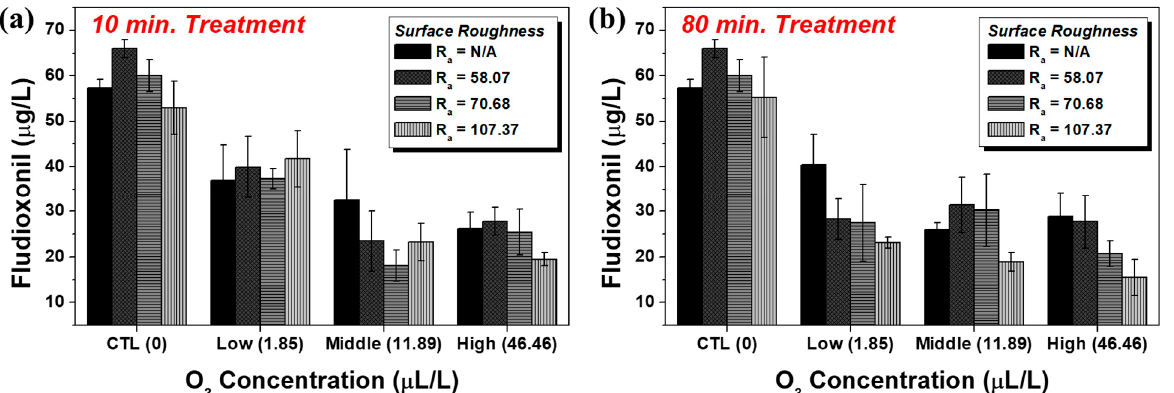
Figure 5. Measured concentrations of plasma treated fludioxonil depending on different R a values, O 3 concentrations and ( a ) 10 min and ( b ) 80 min treatment time conditions are depicted. All values represent the mean and error bars represent the standard deviation of three repeated measurements.